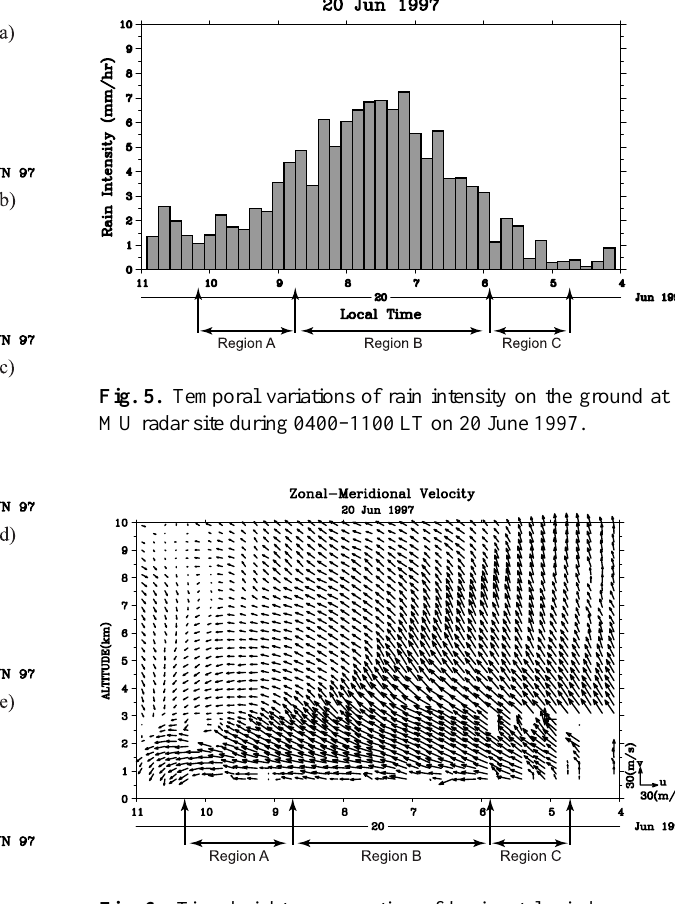
Fig. 4. Temporal variations of (a) pressure, (b) humidity, (c) tem- perature, (d) wind direction, and (e) wind speed on the ground at the MU radar site during 0400–1100 LT on 20 June 1997.